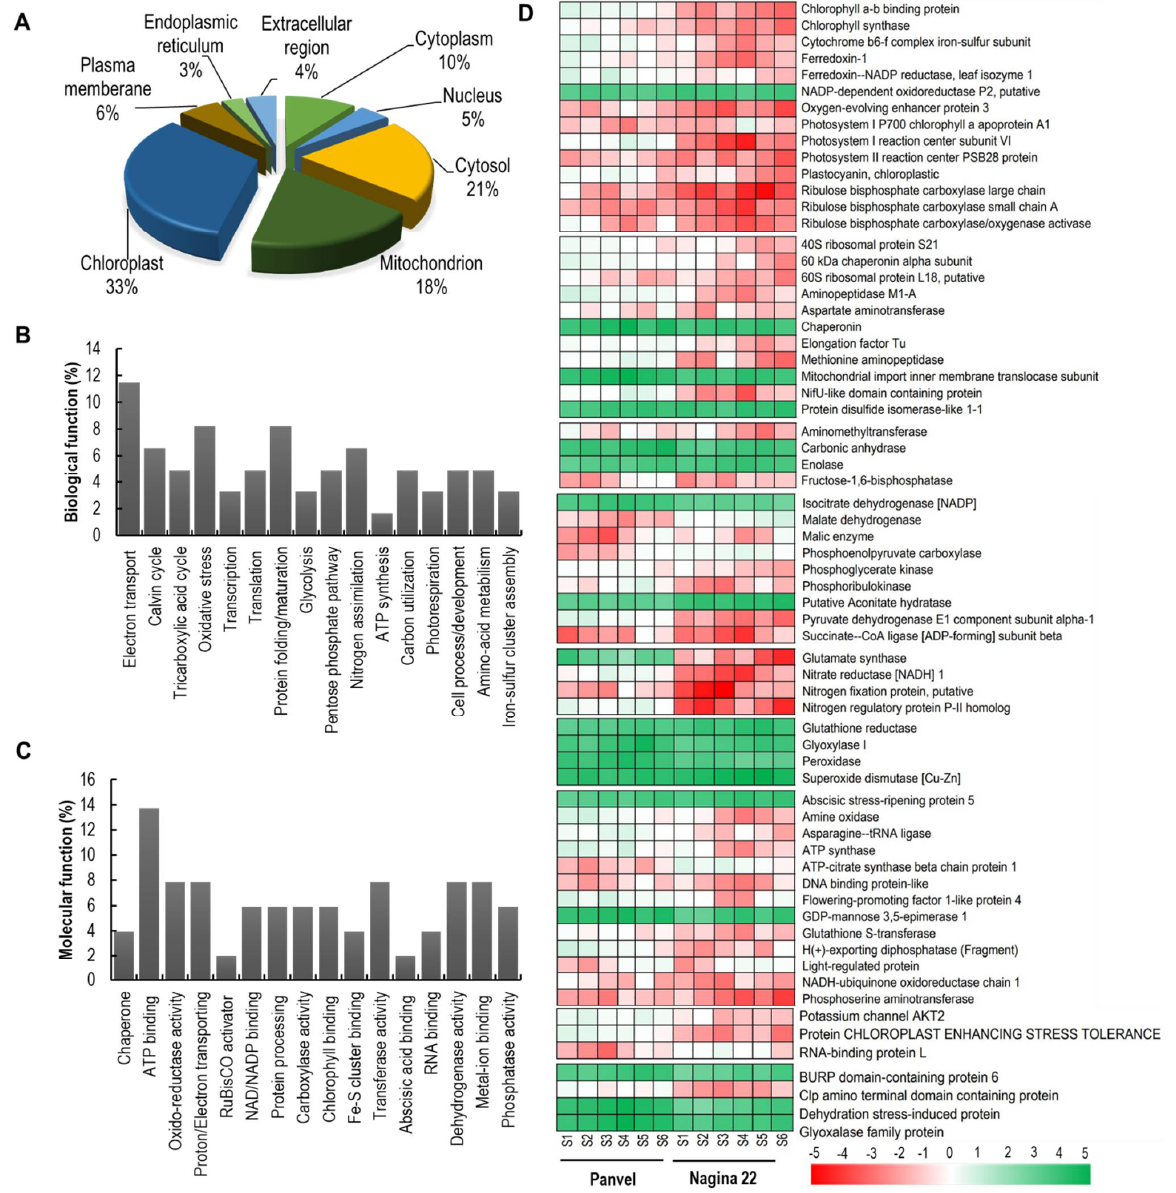
Figure 6. Spatial and functional distributions and heatmap of identified differentially expressed proteins (DEPs) at different growth stages of Panvel and Nagina 22. Cell component contribution of DEPs ( A ) and percentage of DEPs in different biological ( B ) and molecular ( C ) processes. Heatmap of identified DEPs at six specific growth stages (S1–3rd tiller, S–6th tiller, S3–flag leaf, S4–booting, S5–panicle, and S6–milk stages) of rice cultivars Panvel and Nagina 22 ( D ). The fold–change of upregulated protein spot volumes was calculated with treatment/optimum, whereas the fold–change of downregulated protein spot volumes was calculated with optimum/treatment. More than 2–fold relative expressed spots were considered as differentially expressed between